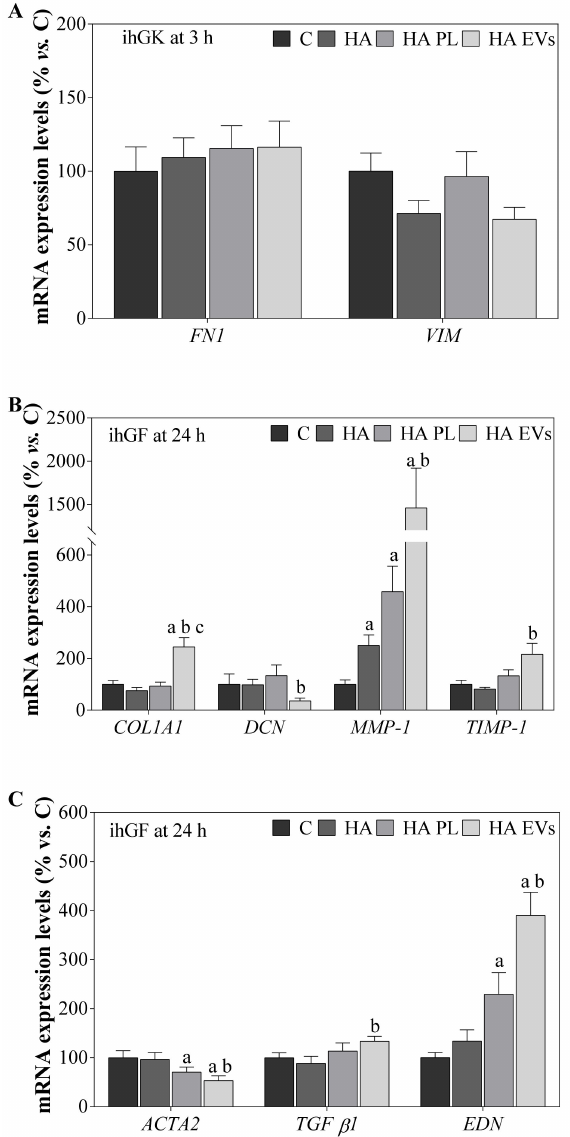
Figure 6. Gene expression levels in ihGK and ihGF after HA, HA-PL, and HA-EV treatment. ( A ) Ef- fects on ihGK mRNA expression levels of FN1 and VIM after 3 h of treatment. ( B ) Effects on ihGF mRNA expression levels of COL1A1 , DCN , MMP-1 , and TIMP-1 after 24 h of treatment. ( C ) Effects on ihGF mRNA expression levels of TGF- β 1 , EDN , and ACTA2 after 24 h of treatment. Values represent the mean ± SEM. For ihGK, 9 independent experiments, with at least duplicate wells per group ( n = 9), were performed, while for ihGF, 7 independent experiments, with at least duplicate wells per group ( n = 7), were performed. Results were statistically compared by paired t -test. Statistically significant differences were considered for p < 0.05 and represented with “a” compared to C, with “b” compared to PL and with “c” compared to HA